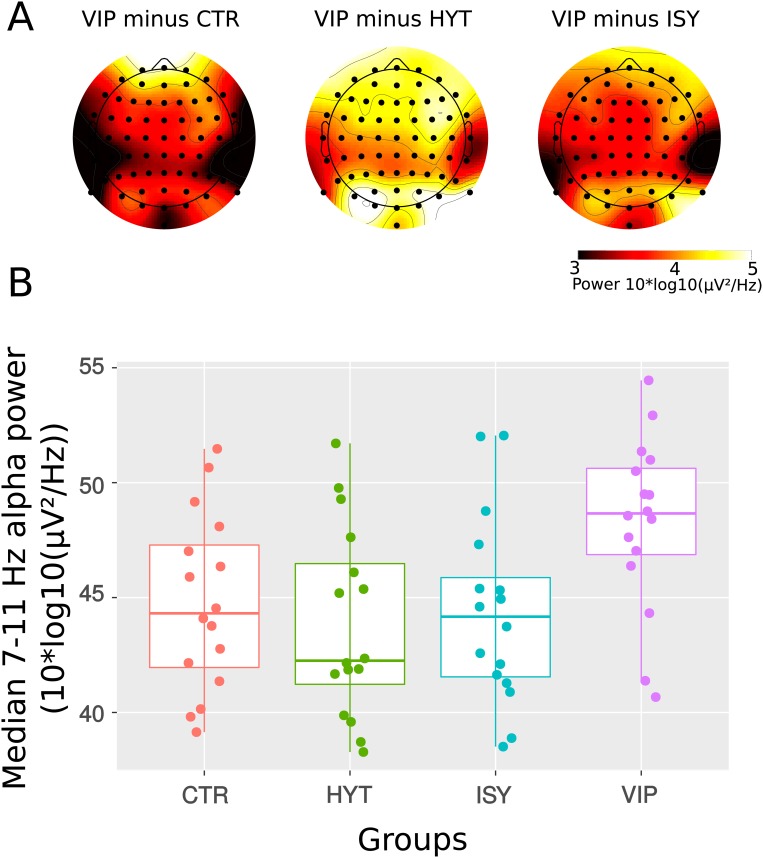
A. Spectral differences in the 7–11 Hz range between the Vipassana group and the control, the Himalayan Yoga and the Isha Yoga groups. A black dot indicates significance at p<0.01 for a given electrode site after correction for multiple comparisons (see Material and Methods). B. Distribution of individual median 7–11 Hz activity over all electrodes during meditation in each group.